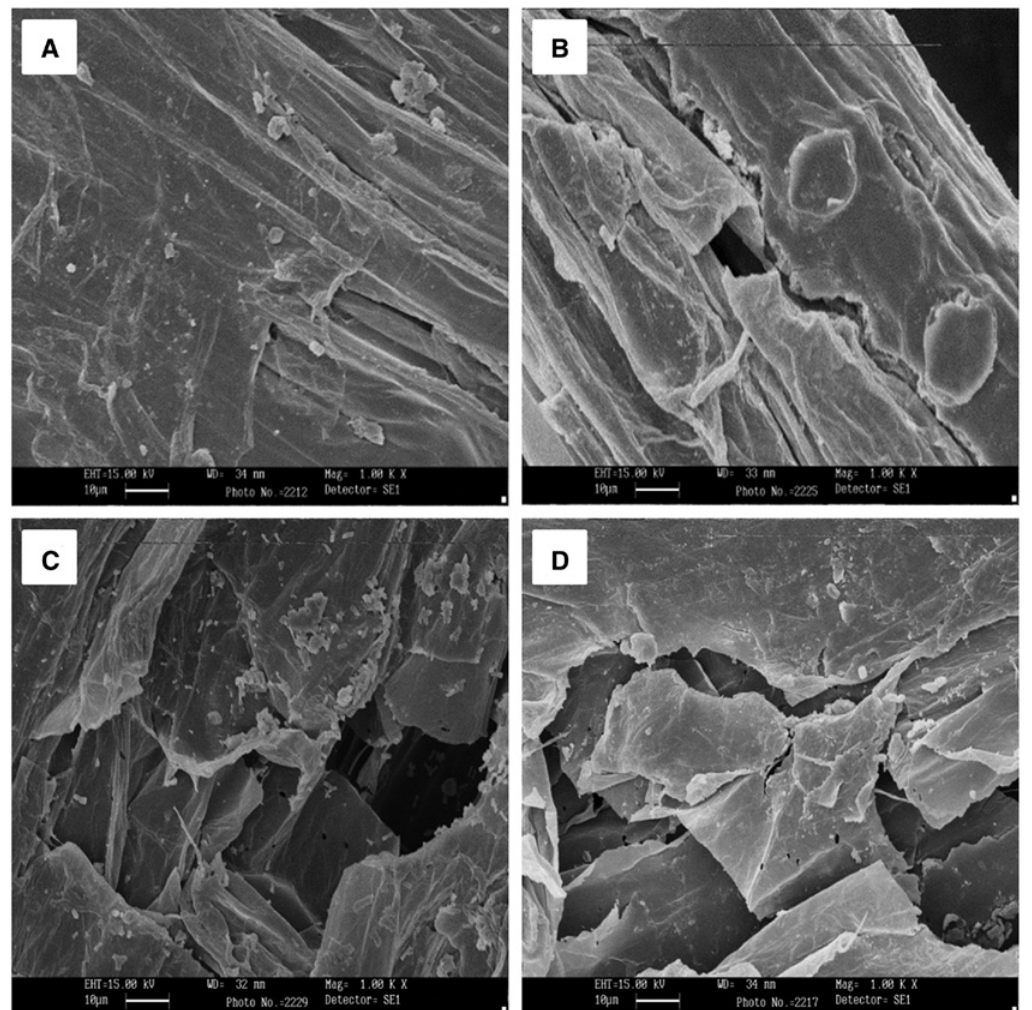
Figure 6: SEM morphology of wheat straw: (A) untreated, (B) treated with 1% NaOH, (C) treated with 3% NaOH, and (D) treated with 5%